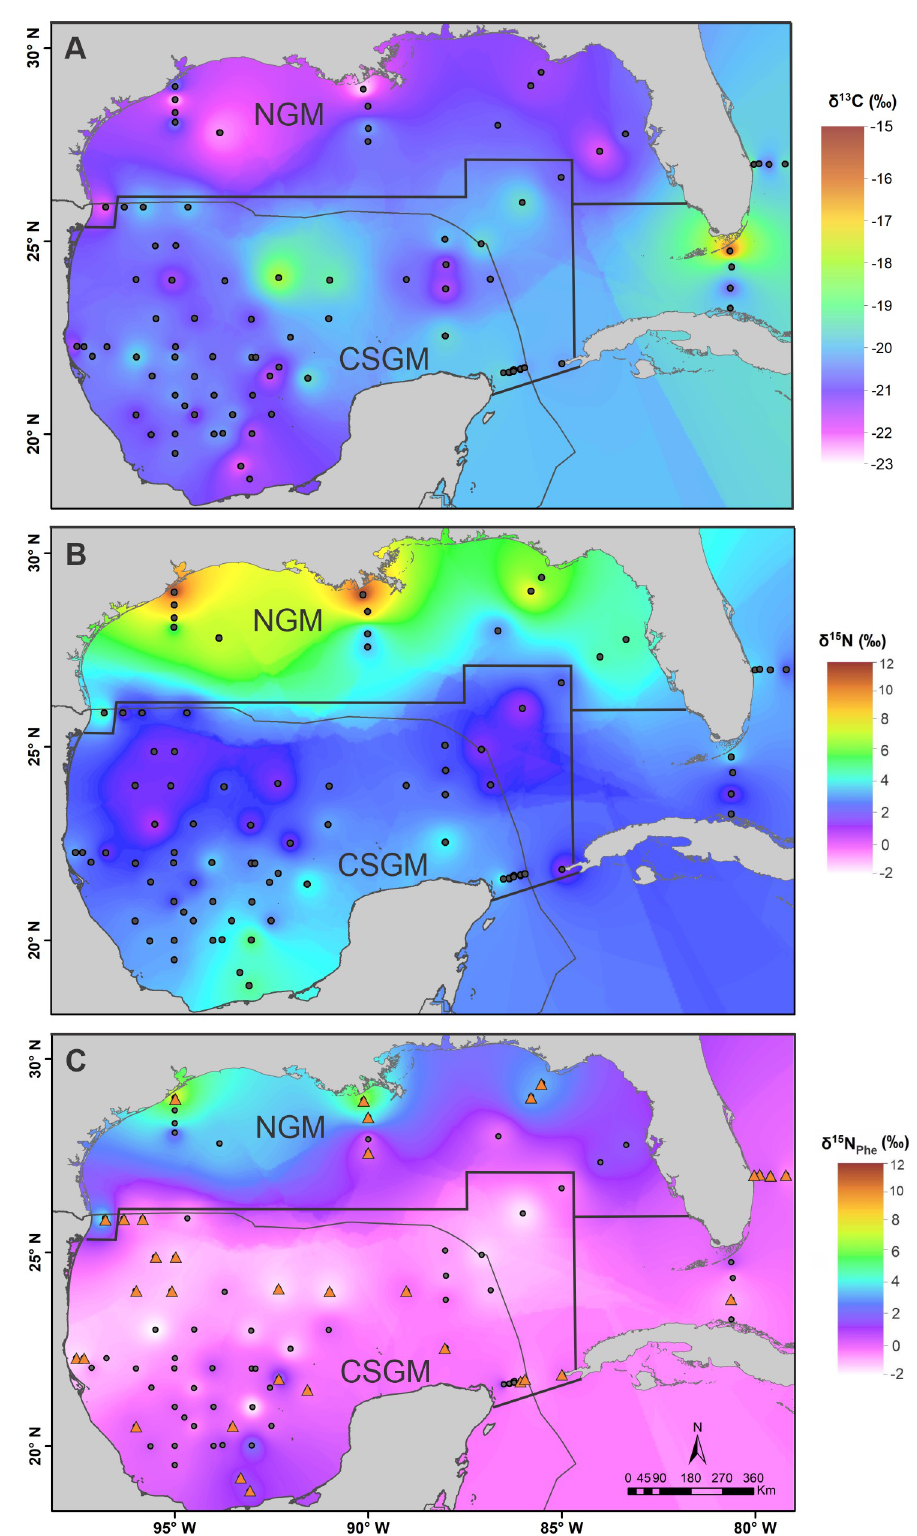
Fig 5. Gulf of Mexico isoscapes. Gulf of Mexico (GM) zooplankton-based (A) δ 13 C and (B) δ 15 N isoscape generated from 335–1000 μ m zooplankton using an IDW interpolation. The solid black polygon delimits the